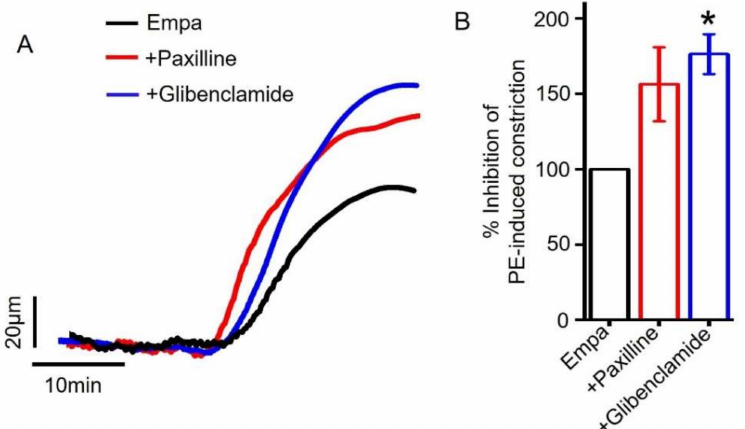
Figure 7. Role of smooth muscle cell BK Ca and K ATP channels in empagliflozin-induced vasodilation. ( A ) Original traces showing that the inhibition of BK Ca and K ATP channels (by 10 µ M paxilline and 10 µ M glibenclamide, respectively) does not reduce Empa-induced vasodilation in resistance-size mesenteric arteries. ( B ) Mean data showing that BK Ca and K ATP channel inhibition does not attenuate Empa-induced vasodilation, n = 3–5. * p < 0.05 vs.